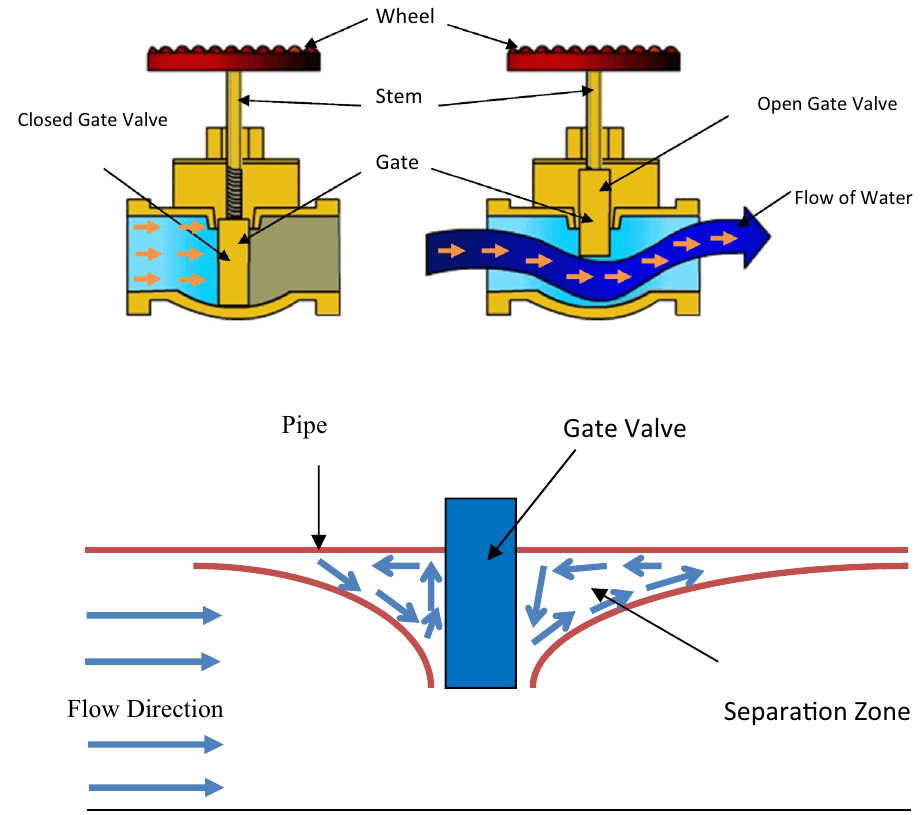
Fig. 1 Gate Valve with its com- ponents at closed and open condition